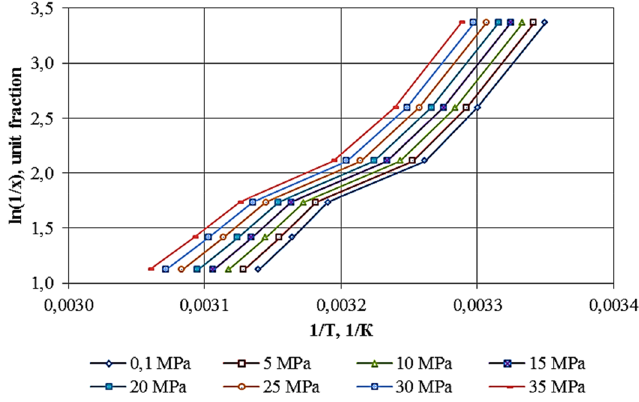
Fig. 11 Van`t Hoff plots for dif- ferent pressure (Struchkov and Rogachev